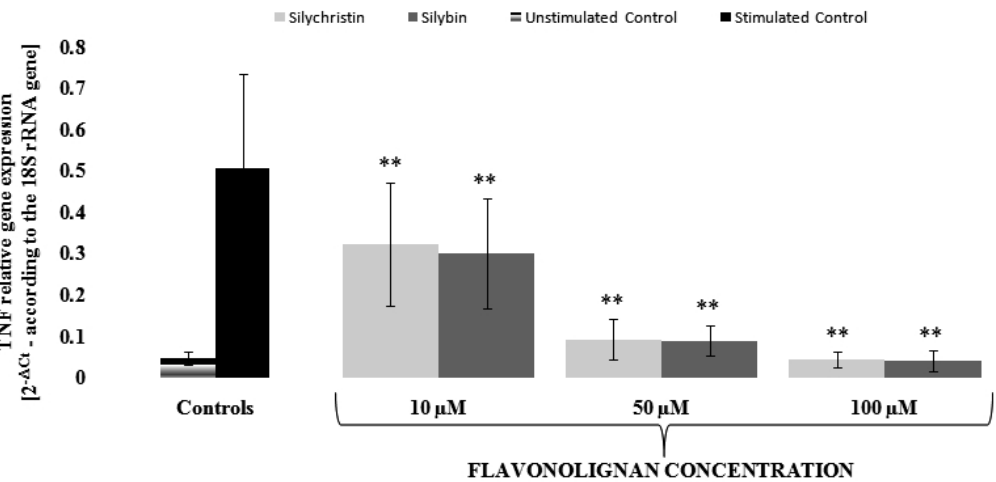
Figure 4. The effect of flavonolignans; silychristin and silybin in concentrations of 10, 50, and 100 µM on the IL-1 β (10 ng/mL) induced the expression of TNF gene (measured at the mRNA level). The results are expressed as a mean of 2- ∆ ct (according to the reference gene—18 S rRNA ) ± SD, n = 12; ** p < 0.001.